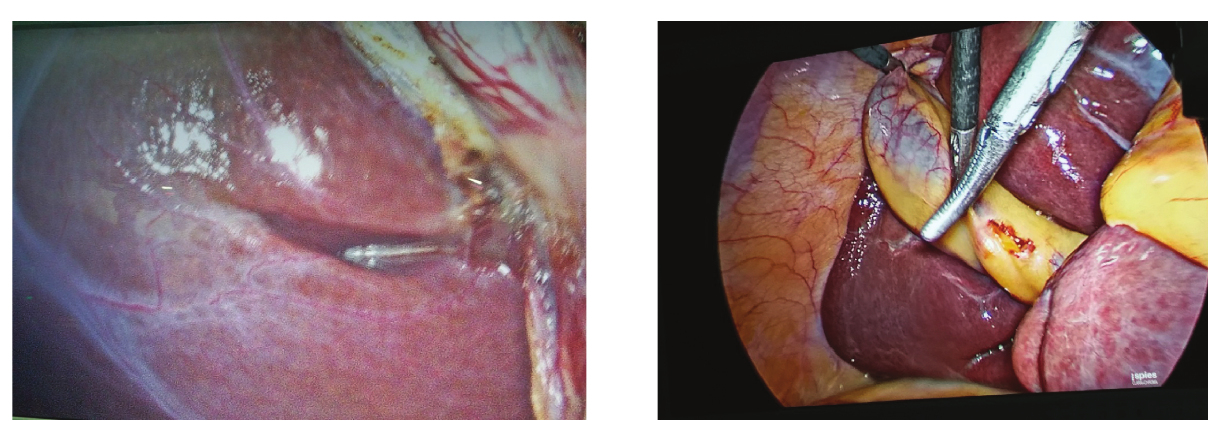
Figure 3: Slit type, oblique RS.